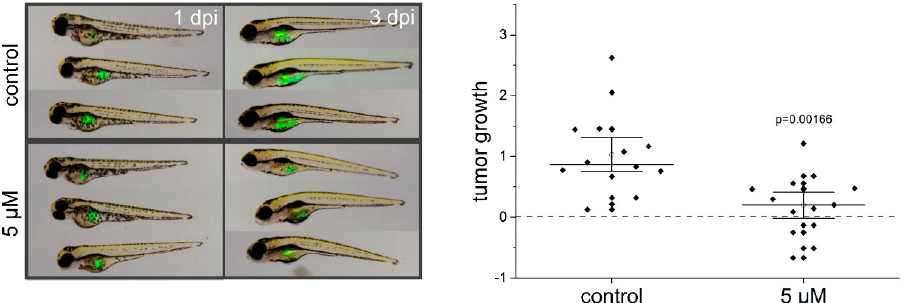
Figure 5. ThioA inhibits proliferation in vivo. Stably enhanced green fluorescent protein (EGFP)- expressing Huh7 cells were injected into the yolk sac of zebrafish embryos 48 hpf (hours post